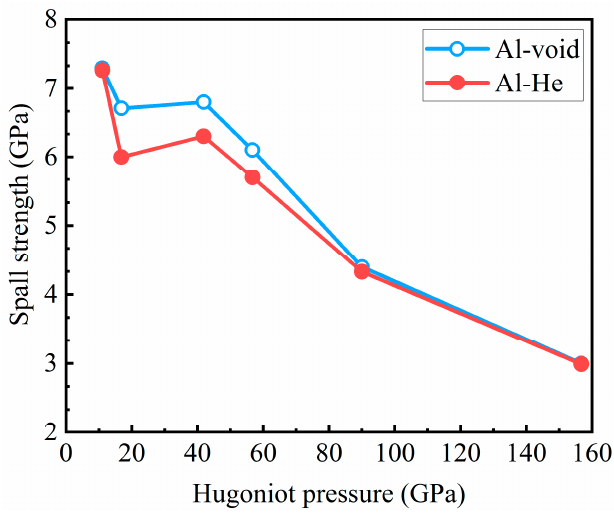
respectively). This indicates that the hindering effect of the He bubble on the void nucle- Figure 7. Spall strength of Al–void and Al–He under various Hugoniot states. Figure 7. Spall strength of Al–void and Al–He for different Hugoniot states. ation and growth decreases with the increasing pressure.